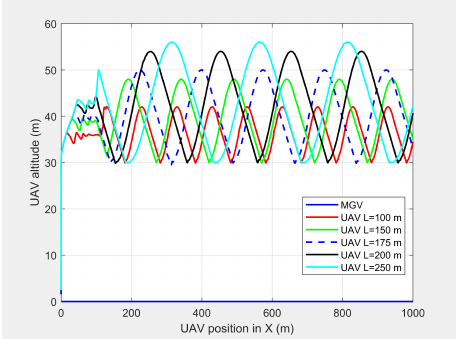
Figure 7. The UAV’s altitude when following the MGV for different L values.